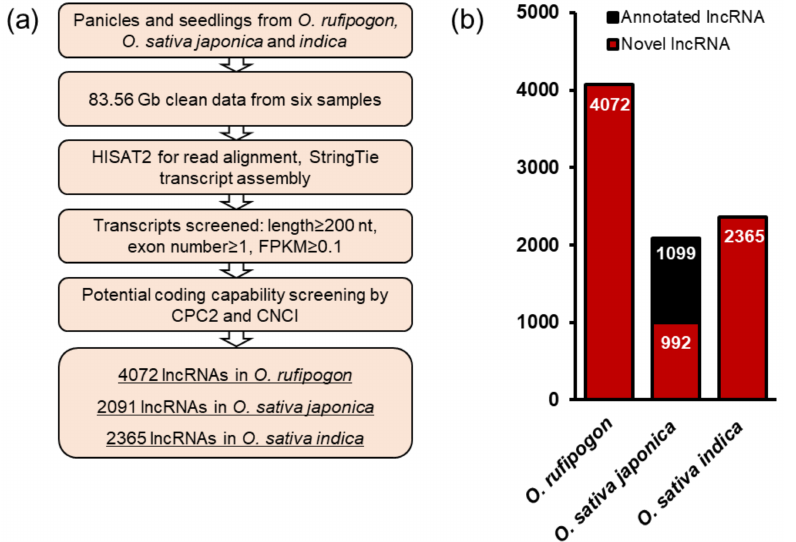
Figure 1. Identification of lncRNAs from wild and cultivated rice. ( a ) Pipeline used to identify lncRNA transcripts in this study. ( b ) Comparison of lncRNAs identified in this study from previously annotated rice lncRNAs. The red box represents the number of novel lncRNAs identified in this study, and the black box indicates the number of previously annotated lncRNAs in the literature [21,28] that are included in our datasets.